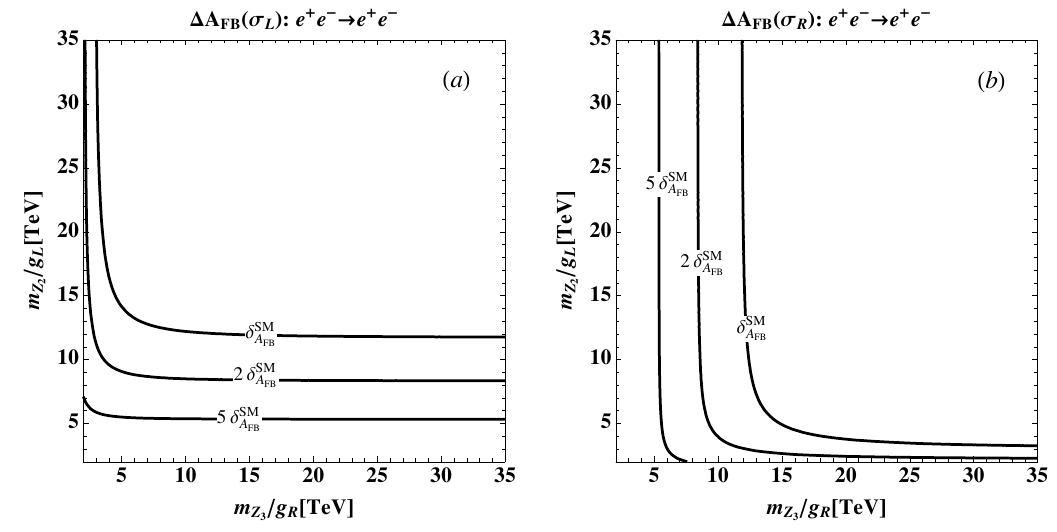
Figure 1 . The contours of (cid:1) A FB de(cid:12)ned as eq. (3.12) on the m Z